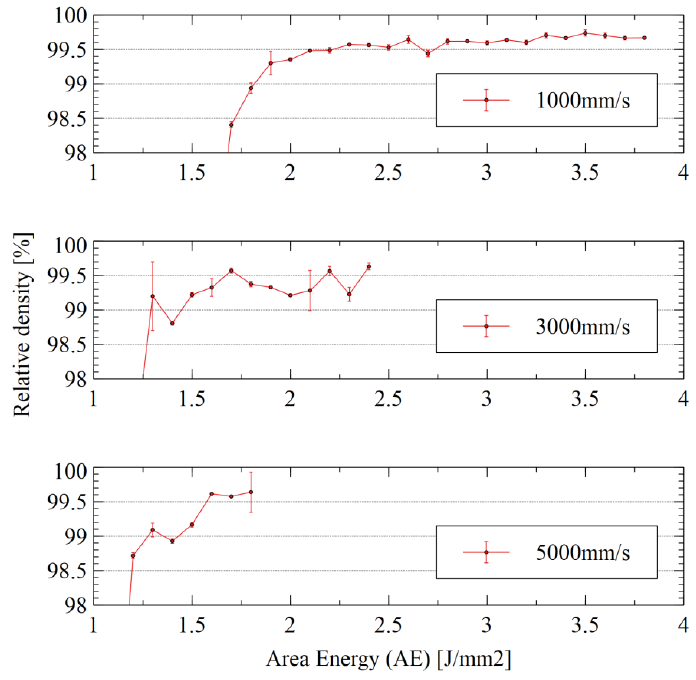
Figure 4. Relative density measurement results (arithmetic mean ± SD) for different beam deflection rates and area energies. The impact of different process parameters on surface topography was visually clear. While density measurement showed that lower beam deflection rates resulted in higher relative density, the visual surface quality in terms of apparent surface roughness im- proved with higher deflection rates (Figure 3). One could hypothesize that this was an effect of melt pool dynamics, where the lower beam deflection rate caused the material to completely solidify between beam passes. The higher beam deflection rate may have en- tered a dynamic regime where the adjacent melt track was at least partly in a liquid state, thus combining the two melt tracks more seamlessly. This would also explain why the melt tracks appeared narrower at lower beam deflection rates, even though the opposite situation would be a reasonable assumption given the higher area energy input. This hy- pothesis is supported by the cross sections of samples a, b, and c (see Figure 5), with melt track widths of average (SD): 254 µm (38.3), 442 µm (78.8), and 649 µm (27.5), respectively.